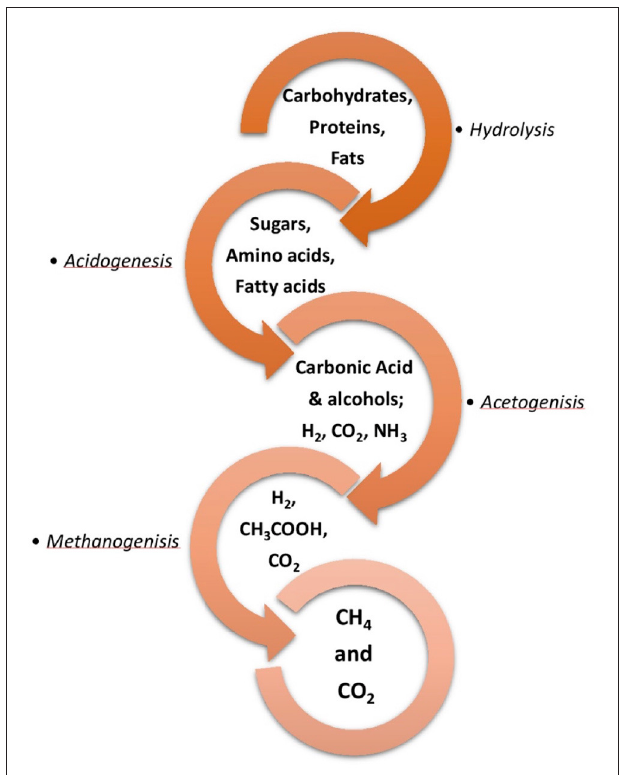
FIGURE 1 | Four stages of the anaerobic digestion